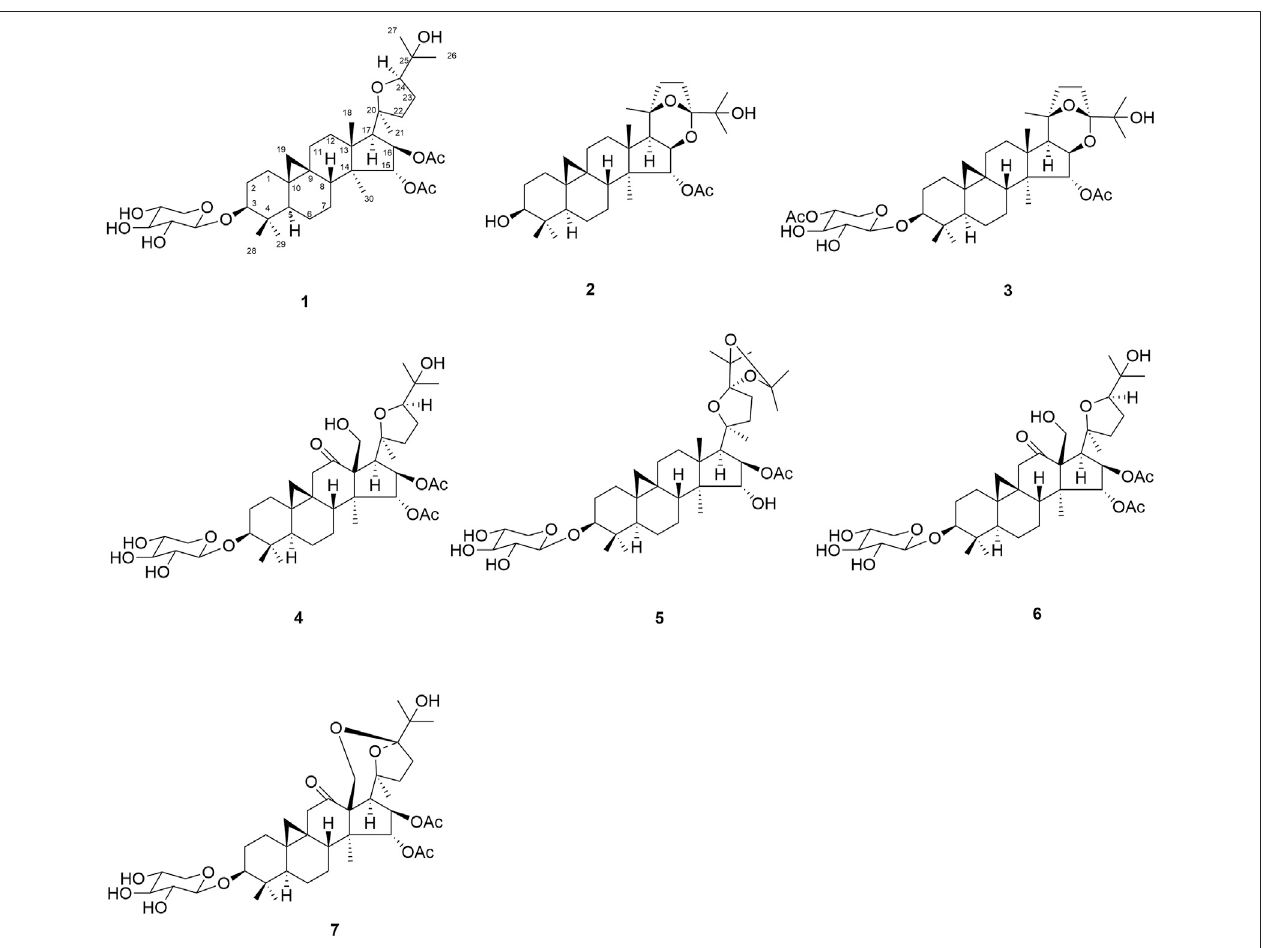
FIGURE 1 | Structures of compounds 1 – 7